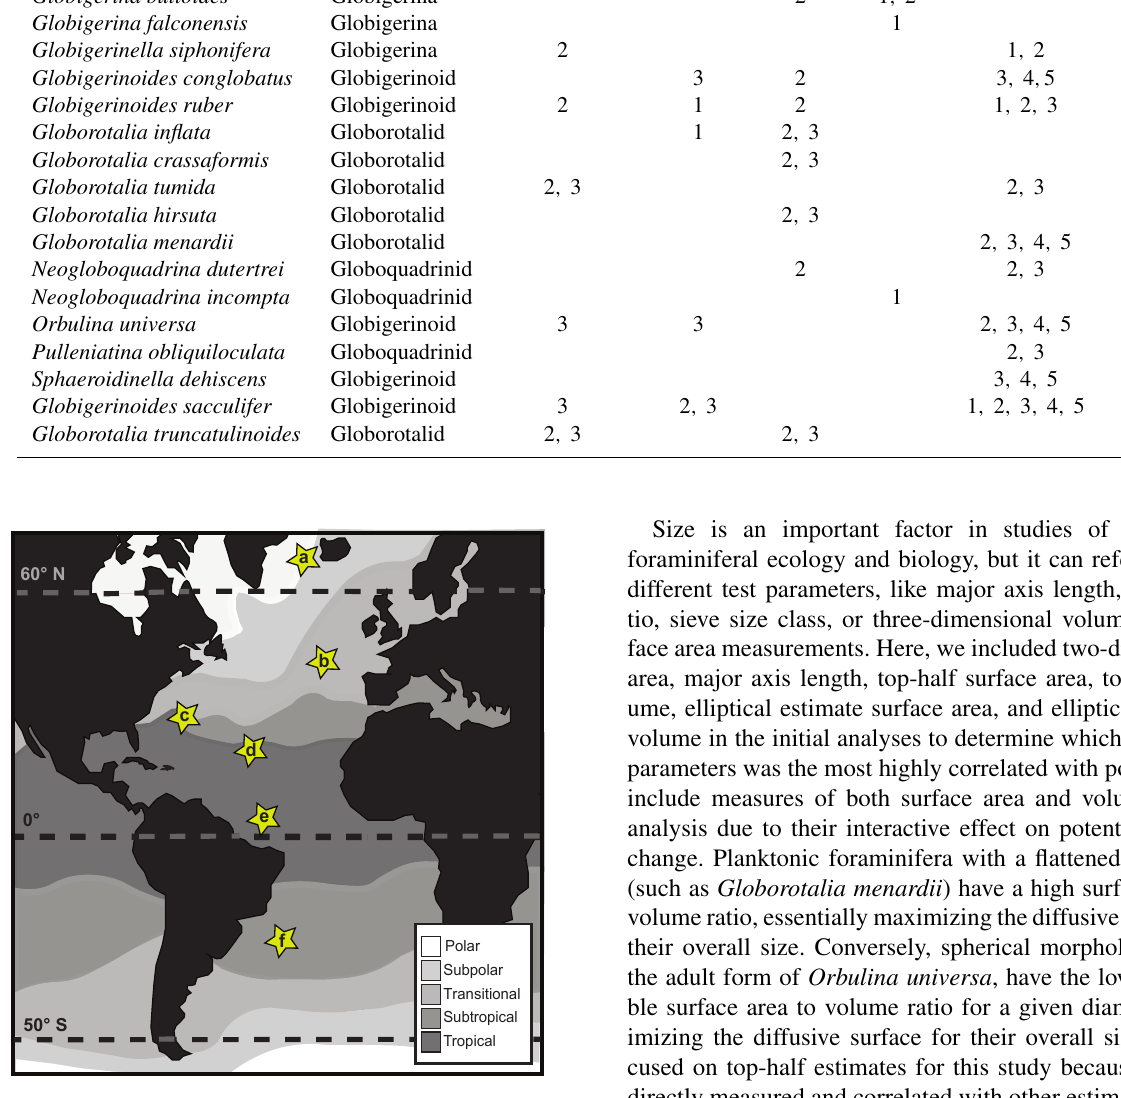
Figure 1. Map of core-top sample localities (modified from Dar- ling and Wade, 2008): (a) EW9303-04: 64.71 ◦ N, − 28 . 91 ◦ E, sub- polar; (b) CH82-21: 43.288 ◦ N, − 29 . 83 ◦ E, transitional; (c) VM20- 248: 33.5 ◦ N, − 64 . 4 ◦ E, subtropical/tropical; (d) AII-42-15-14: 19.567 ◦ N, − 44 . 95 ◦ E, tropical; (e) KC78: 5.267 ◦ N, − 44 . 133 ◦ E, tropical; (f) AII-60-10: − 29 . 6 ◦ N, − 34 . 667 ◦ E, subtropical.